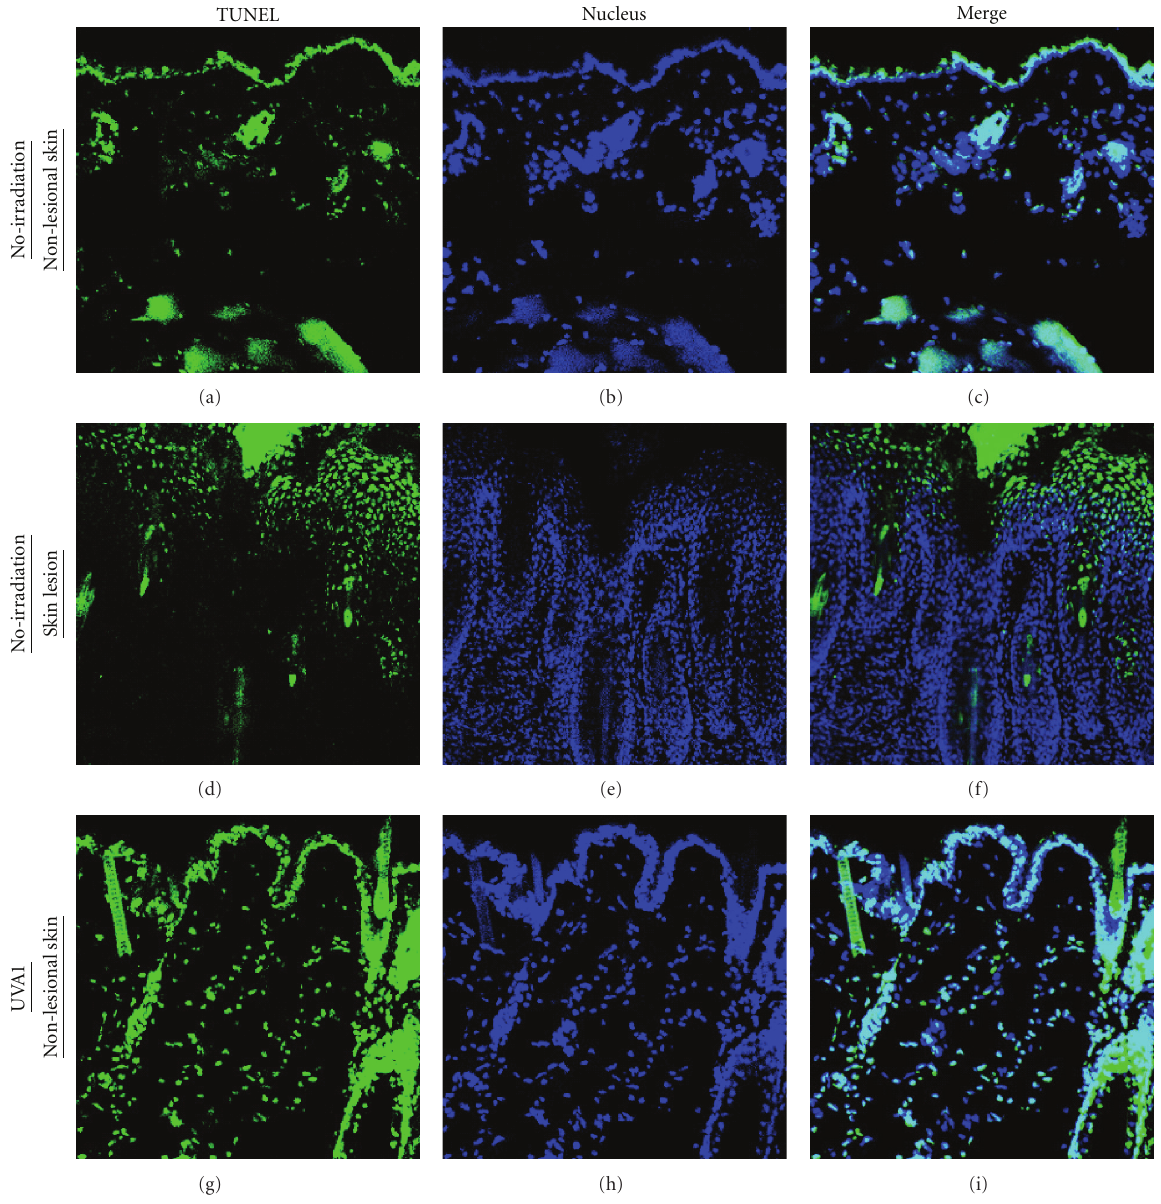
Figure 6: TUNEL assay for the analysis of apoptotic cells in the skin of MRL/lpr mice. (a), (b), (c): nonlesional skin of nonirradiated mice. (d), (e), (f): spontaneous LE-like skin lesion of nonirradiated mice. (g), (h), (i): nonlesional skin of UVA1-irradiated (10J/cm 2 ) mice. Positive cells for TUNEL assay are shown in green, whereas the nuclei are labeled with Hoechst 33342 in blue. In the nonlesional skin of the UVA1-irradiated (10J/cm 2 ) mice, TUNEL-positive cells were scattered in the dermis (g), (i). However, TUNEL-positive cells were rarely seen in the dermis of the nonlesional skin of the nonirradiated mice (a), (c). In the LE-like skin lesions, TUNEL-positive cells were di ff usely detected in the hypertrophic epidermis, whereas in the dermis TUNEL-positive cells were hardly seen (d), (f). (a), (d), (g): TUNEL assay, (b), (e), (h): nuclear staining, (c), (f), (i): merged images of TUNEL assay and nuclear staining images, original magnification, ×